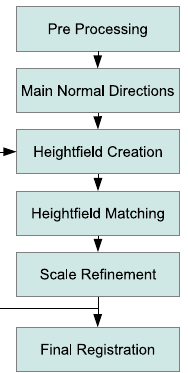
To find dominant normal directions, point normals are estimated for both point clouds and clustered on the unit sphere. Clustering is done with non- parametric density estimation using a circle on the sphere with radius r 0 . 035 (corresponding to a polar cap with 2 ◦ of latitude) as kernel. A Figure 4: Normal di- rections on an unity sphere with the circu- lar kernel marked in red